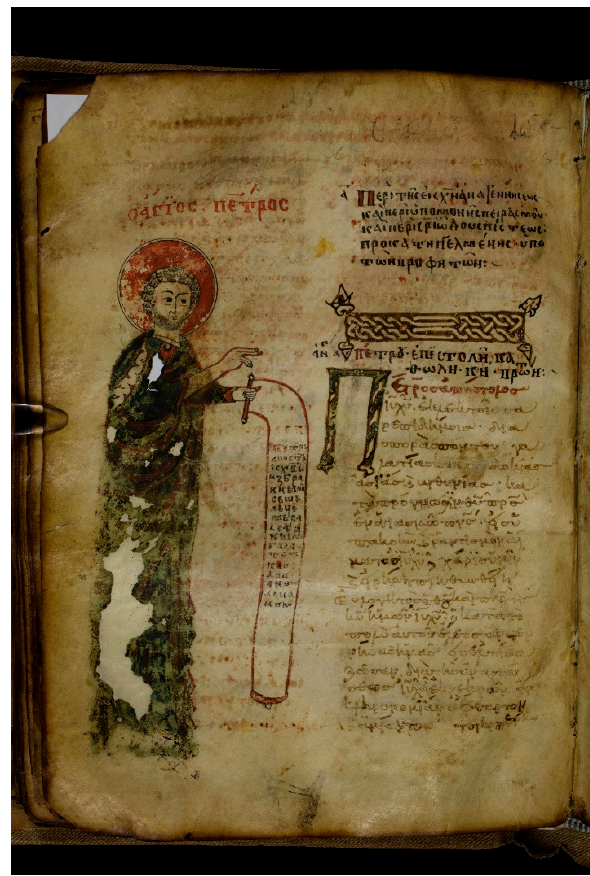
Figure 4. Miniature of the Apostle Peter. National Library of Greece. EBE 149, f. 52v (GA 1875). Ca. 10th century CE. Image used by permission from the National Library of Greece and the CSNTM.